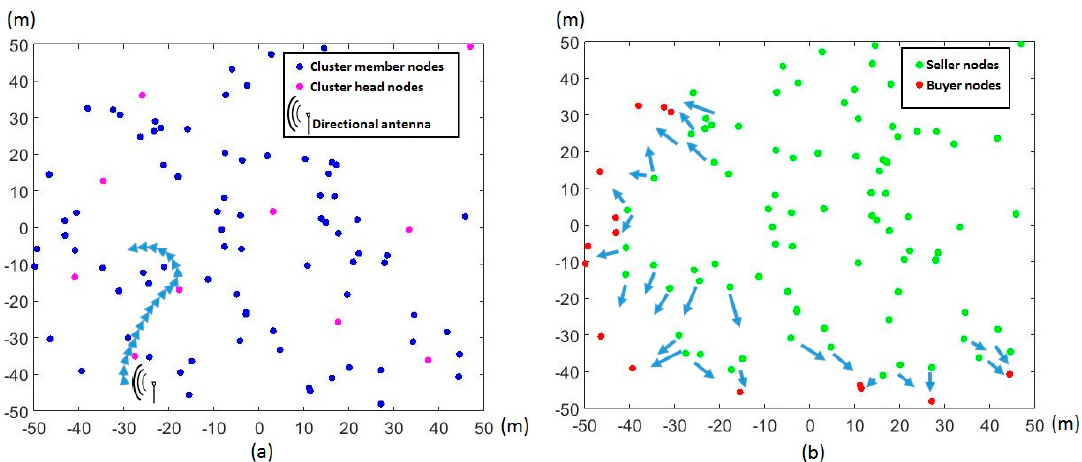
Figure 1. Two stages of the hybrid charging scheme: ( a ) charging by mobile charger in the first stage; and ( b ) energy trading between seller and buyer nodes in the second stage.